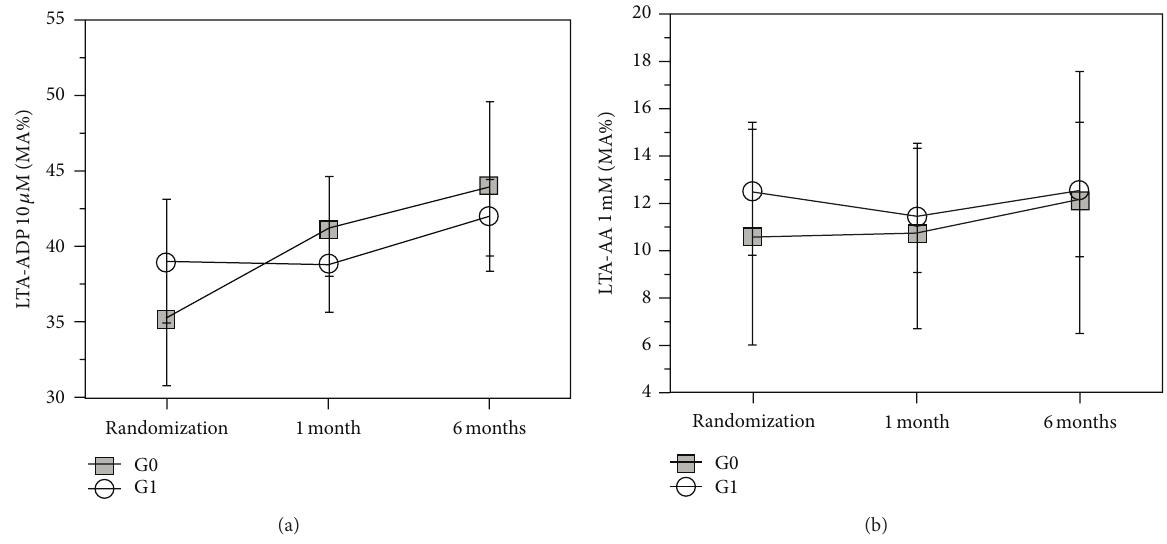
Figure 3: Results of CEPI-CT in G0 and G1 at 5, 30, and 180 days following PCI.